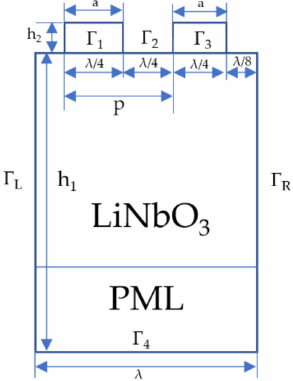
Figure 1. Schematic representation of the single-pair IDT structure in the model.